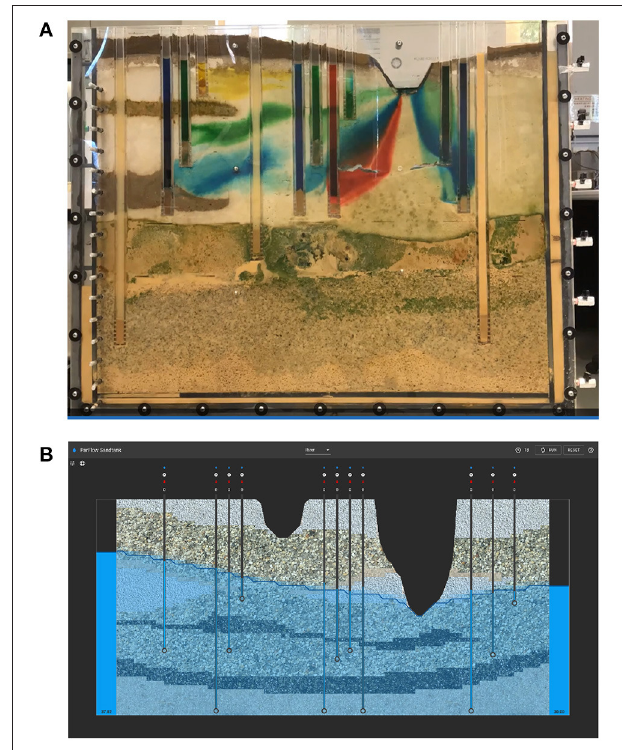
FIGURE 5 | Example of transitioning a hands-on physical aquifer model (A) to a digital analog based on the ParFlow SandTank (B)